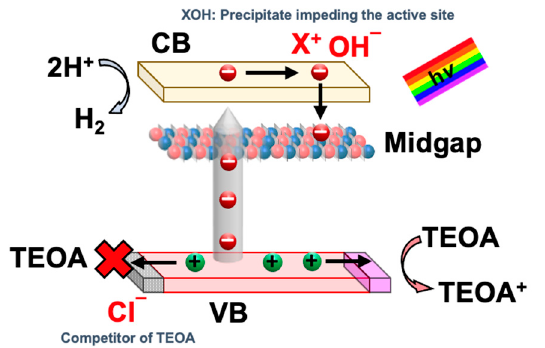
Figure 4. A plausible mechanism of sea salt ions towards HER from seawater splitting using ACN.